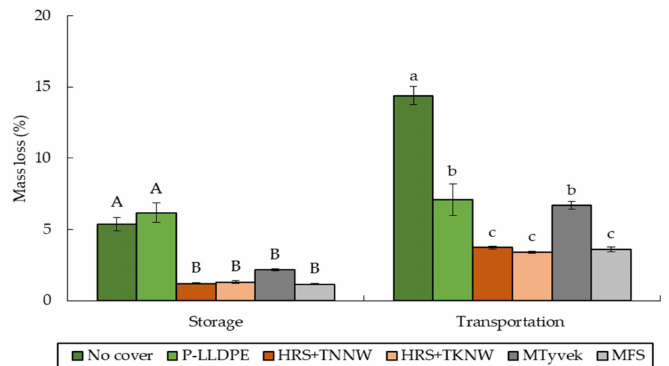
Figure 11. Mass loss (%) among the six treatments after simulated storage at 18 ◦ C for 48 h and simulated transportation at 30 ◦ C for 15 h. For Tukey’s HSD post hoc test, different letters in each simulation test indicate significant differences at p < 0.05. Values are mean ± S.E. from five